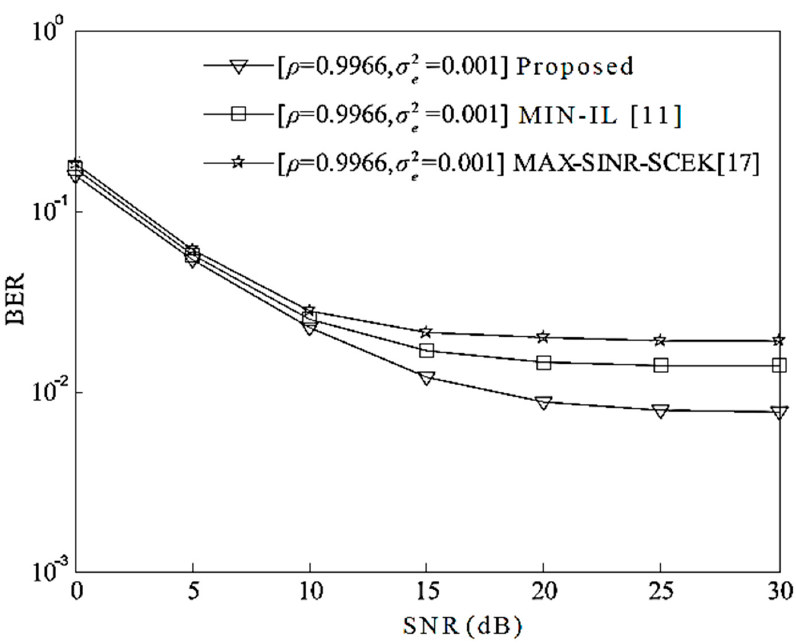
Figure 4. BER comparison under time delay error CSI.